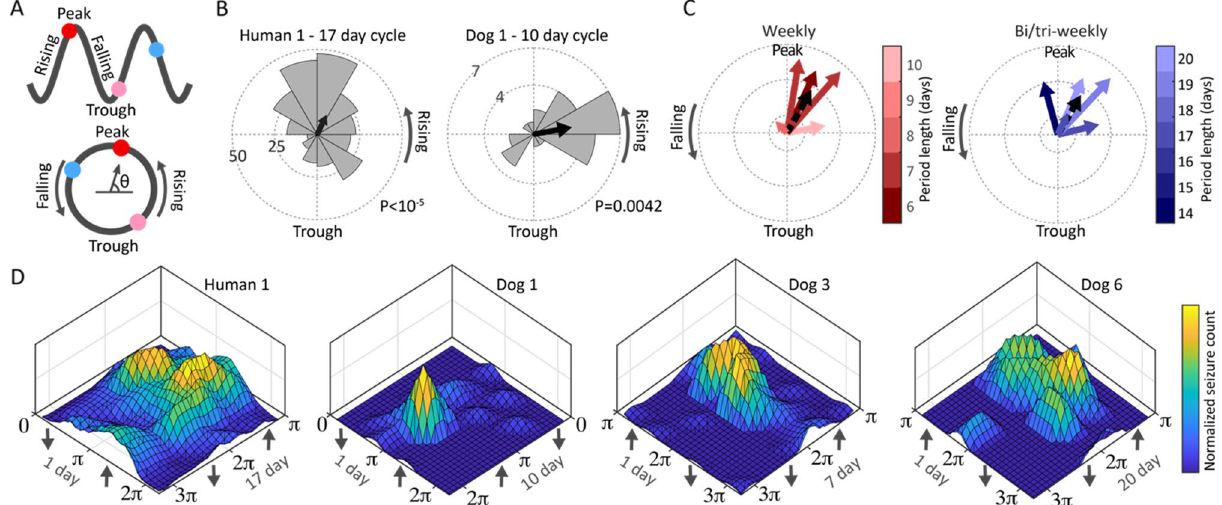
Figure 4. Seizure phase locking to multiday and multiscale spike rate cycles. ( A ) Schematic of the circular representation of IES rate cycles with examples of seizures occurring on IES rate late rising phase (red circle), falling phase (blue circle) and early rising phase (pink). ( B ) Example circular plots of human (H1) and dog (D1) seizure locking to IES phase showing overall preference of seizures for rising IES rate. ( C ) The resultant vector of seizure timing relative to IES rate cycles for subjects with weekly and 2–3 weeklong IES rate cycles (black dashed arrow is group average). Four subjects had significant seizure phase locking to weekly IES rate cycles, and 5 subjects had phase locking to 2–3 weeklong IES rate cycles (P < 0.05). There was a group level seizure phase preference for the rising phase of multiday IES rate cycles. ( D ) Phase–phase plots of seizure phase locking to circadian and multiday spike rate cycles shows the interplay of circadian and multiday cycles. As might be expected, multiday cycles are associated with seizures occurring during existing circadian patterns. D1 dog 1, H1 human